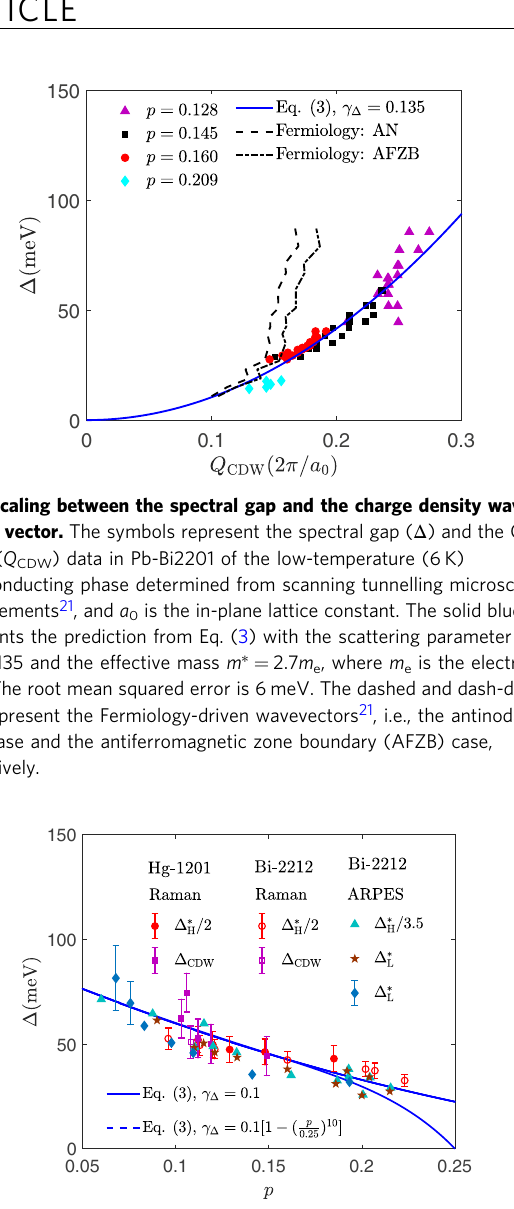
COMMUNICATIONS PHYSICS| (2022) 5:13